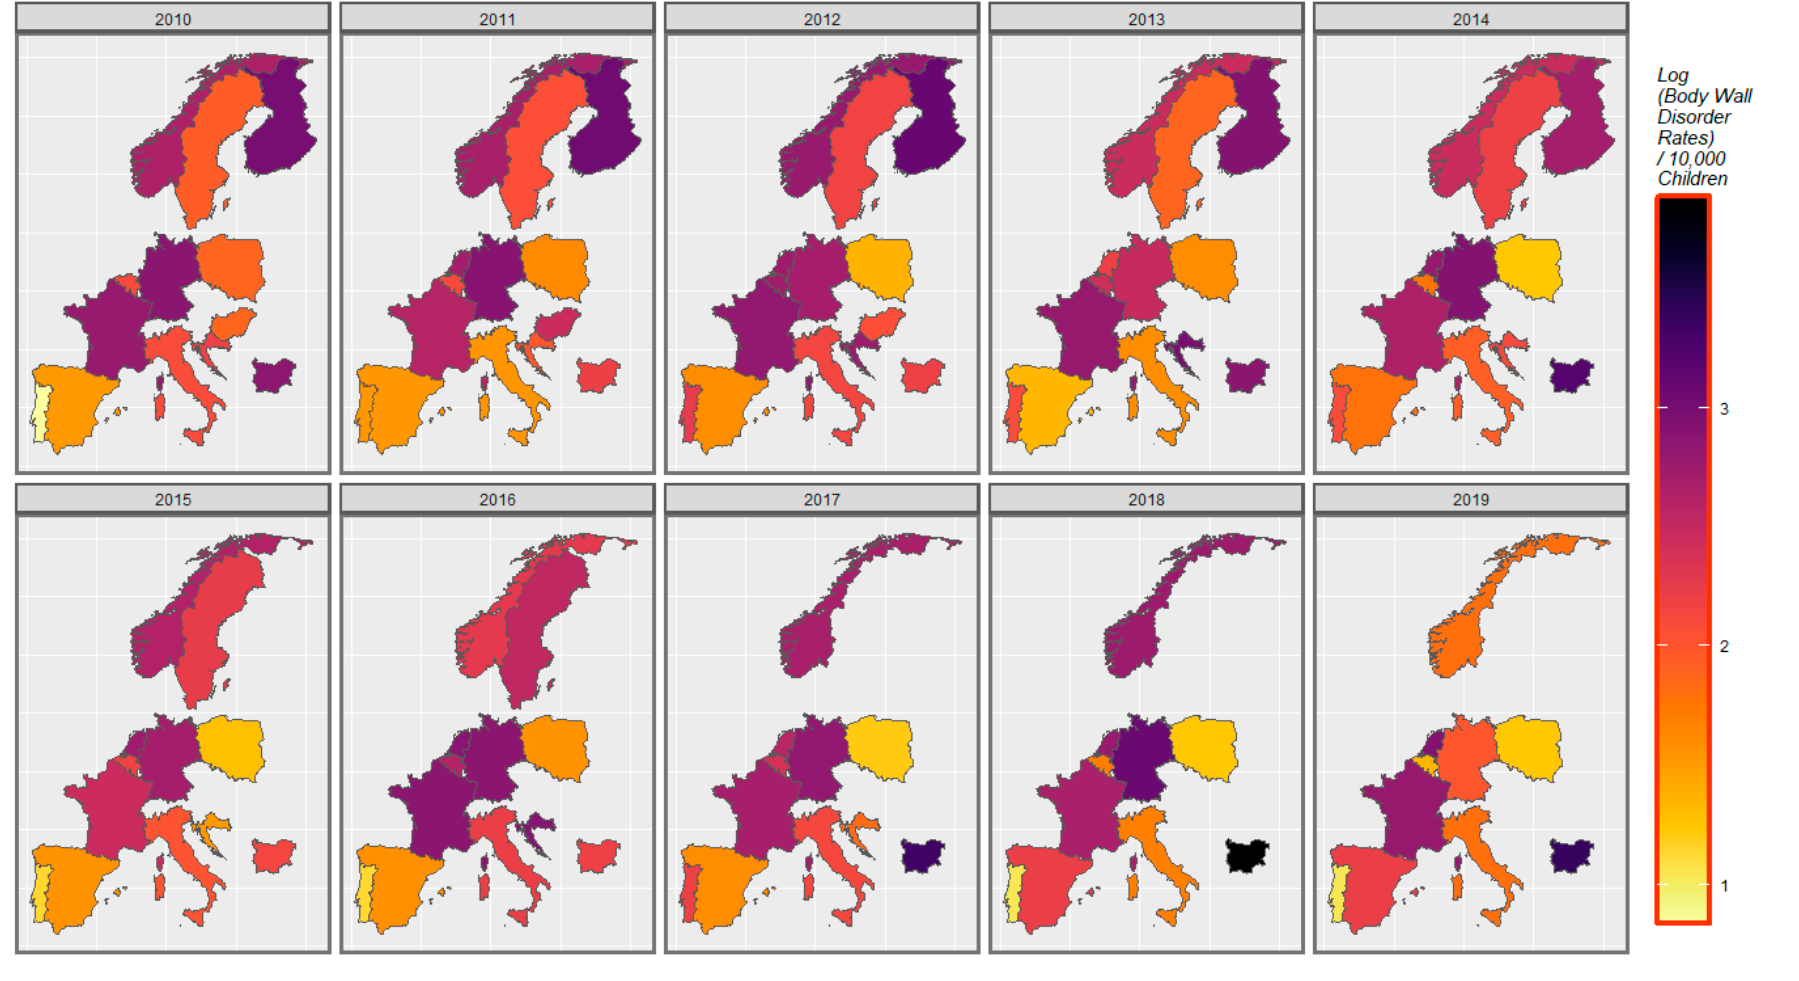
Figure 3. Sequential map-graph of body wall anomalies across selected European nations for each year of 2010–2019.